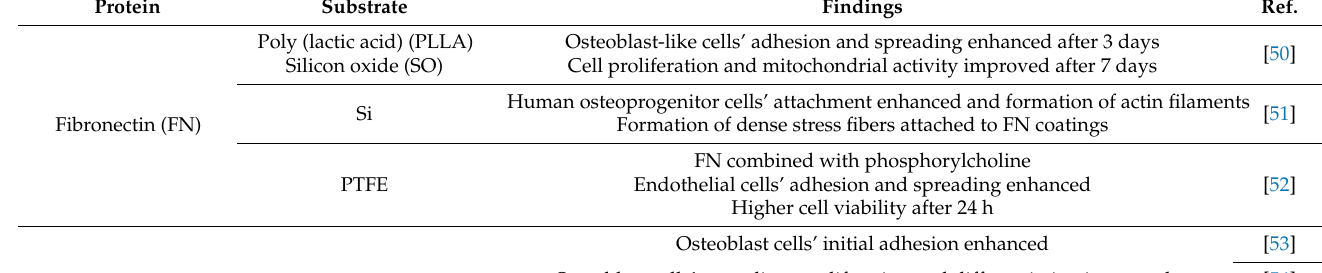
Table 2. Overview of different applications of amine-rich coatings obtained with proteins and the findings associated.